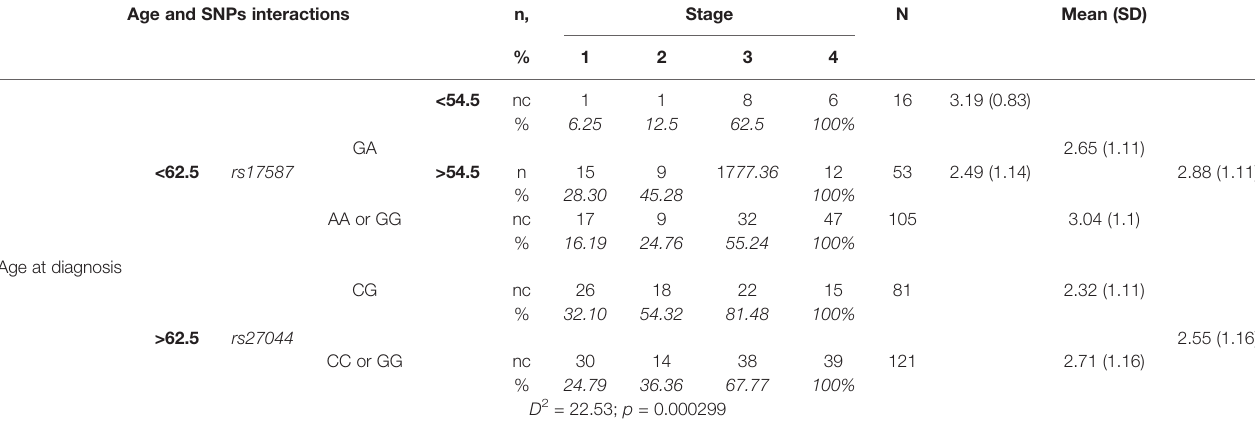
TABLE 5 | Stage of NSCLC according to age at diagnosis and PSMB9 rs17587 and ERAP1 rs27044 polymorphisms. Age and SNPs interactions